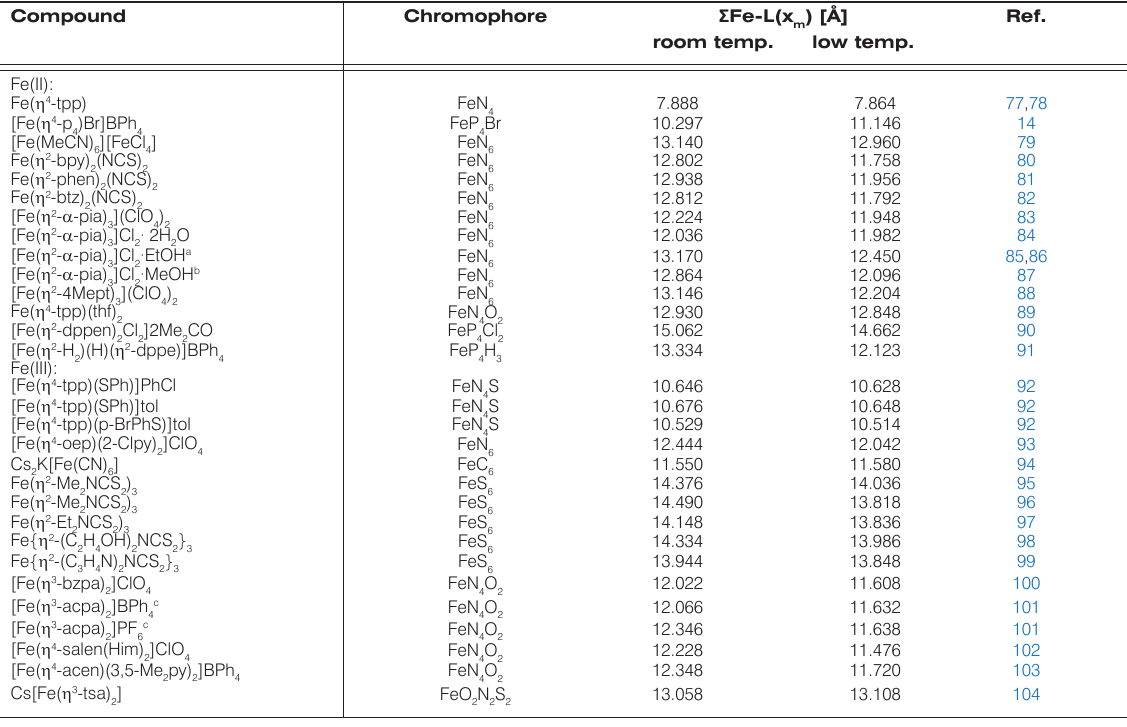
Table 7. Summary of the mean value of Fe – L (xn) (n = 4,5,6 or 7) bond distances Compound Chromophore Σ Fe-L(x